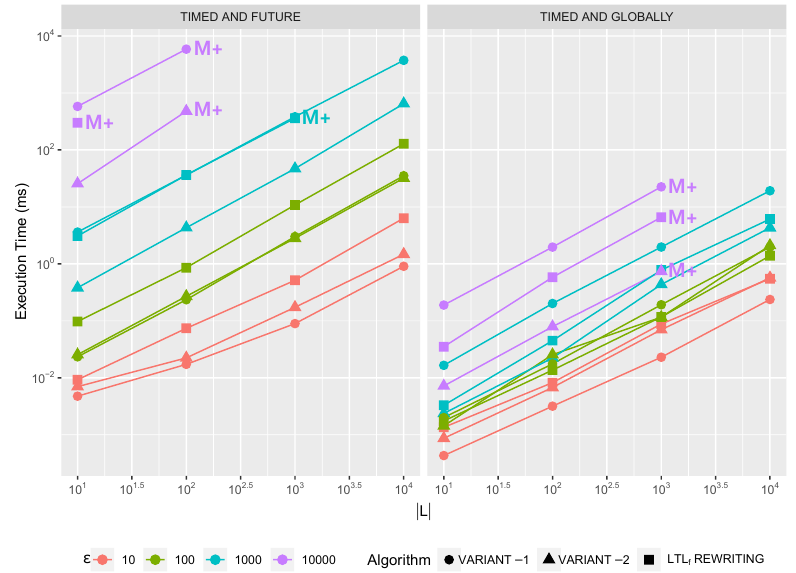
Figure 10. Results for the derived operators T IMED A ND F UTURE and T IMED A ND G LOBALLY Section 6.4. We include both variants of the fast implementations to analyse the environments where each